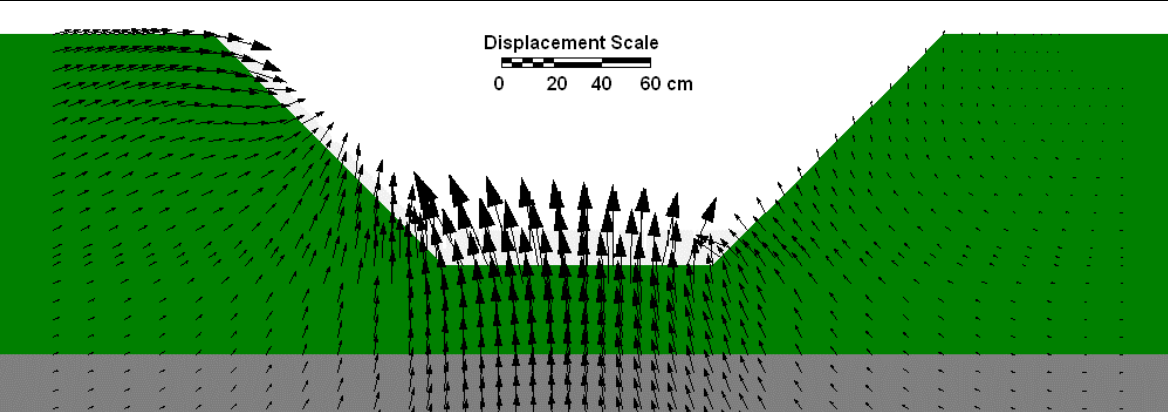
Figure 5. Predicted Displacement Pattern as a Result of Excavating the Left Pit Wall and Pit